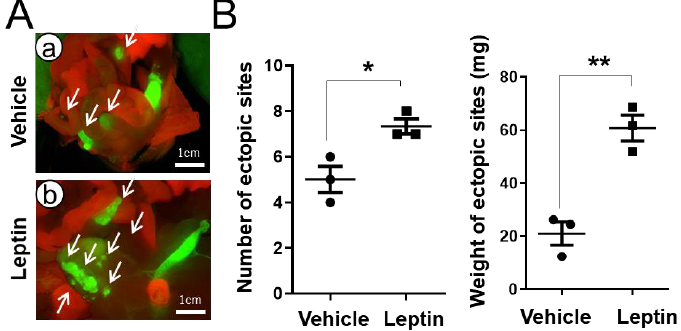
Figure 6. The effect of leptin treatment on endometriosis development. ( A ) Representative images of GFP-positive endometriotic lesions in Pgr cre/+ Rosa26 mTmG mice treated with vehicle ( a ) or leptin ( b ) after endometriosis induction. Pgr cre/+ Rosa26 mTmG mice were induced with endometriosis and then were treated with vehicle or leptin for 2 weeks (3 times intraperitoneal injection per week). Endometriotic lesions were visualized by GFP and arrows indicate ectopic sites. ( B ) The quantification of data for number and weight of ectopic sites were significantly higher in leptin-treated endometriosis mice compared with vehicle-treated endometriosis mice. Data are represented as mean ± SEM. * p < 0.05 and ** p < 0.01. Arrows indicate ectopic sites.